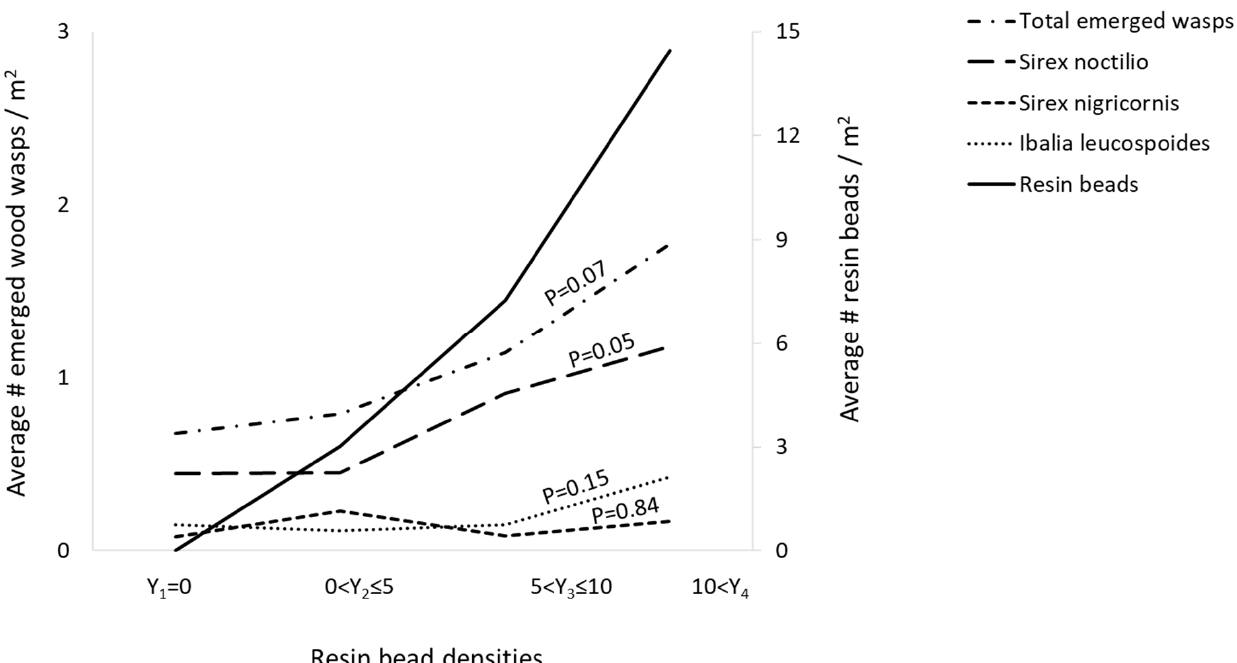
Figure 4. The mean number of emerged wood wasps per square meter collected from infested red